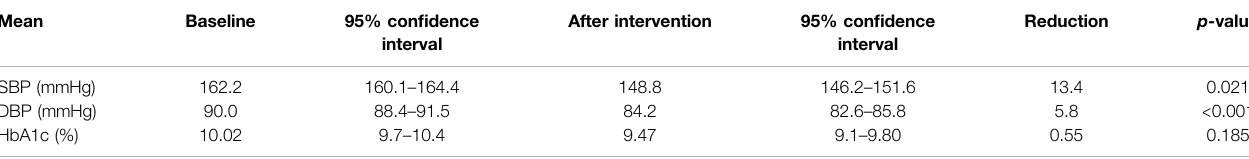
TABLE 2 | Results before and after the intervention for the 276 hypertensive and 71 diabetic patients. Mean Baseline 95% con fi dence